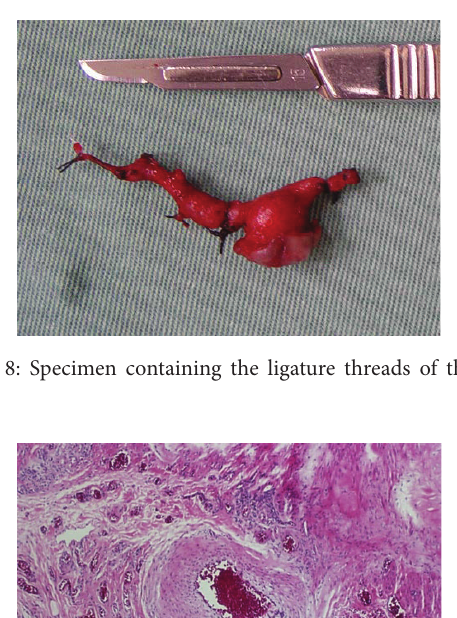
Figure 3: Procedure for excision of the superficial vascular branch, starting with the ligature of the main branches.